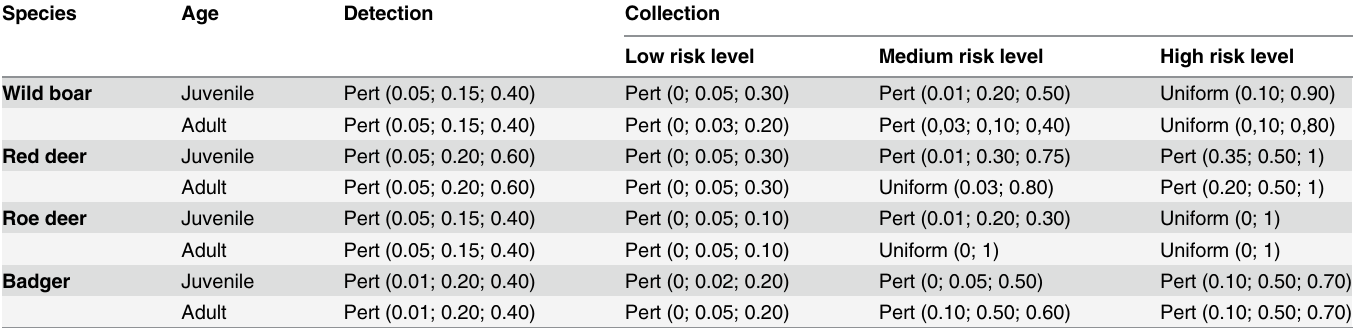
Table 5. Probabilities of a dead or moribund wild animal being detected and collected by a field partner.